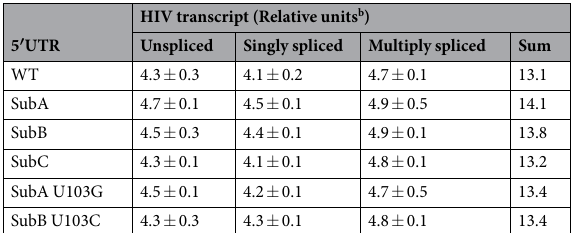
Table 1. 5 ′ UTR substitutions do not change steady state HIV transcript levels a . a Table represents average of three independent experiments ± standard deviation. HEK293 cells were transfected with WT HIV NL4-3 or indicated molecular clone, incubated for 24 h and cell lysate was collected and RNA was extracted. Random primers were used to generate cDNA and qPCR was performed using HIV-specific primers. b Relative units = 1/ cycle threshold × 100.